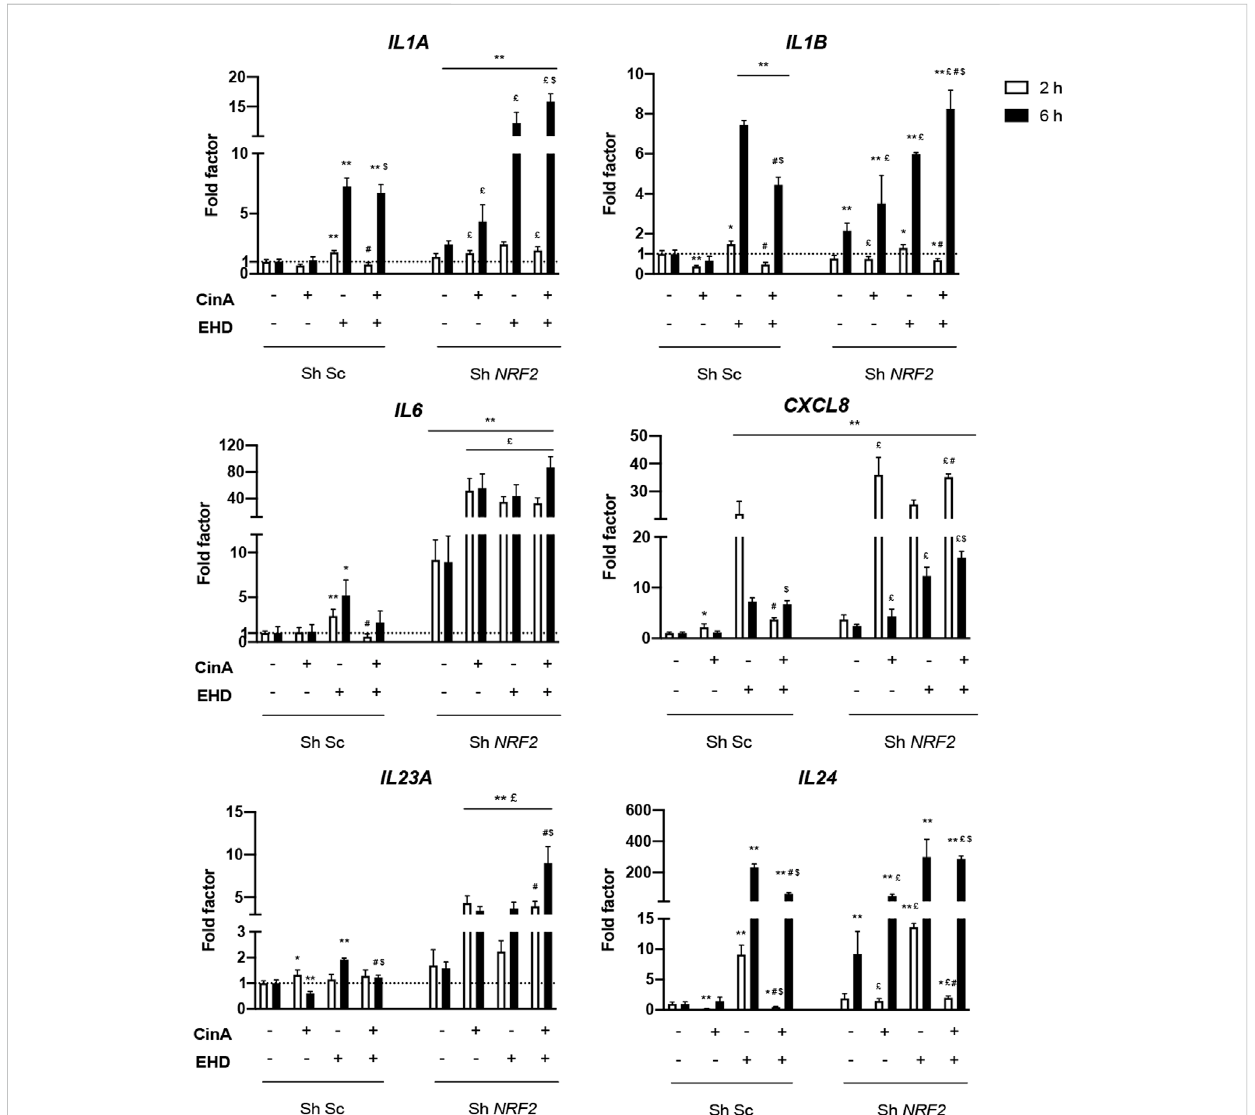
FIGURE 3 NRF2 inhibits in fl ammation in KERTr cells exposed to EHD and the mixture of EHD and CinA . Control KERTr cells (Sh Sc) and NRF2 -invalidated KERTr cells (Sh NRF2 ) were treated for 2 and 6 h with CinA (100 μ M), EHD (10 μ M), a mixture containing CinA and EHD at the same concentrations and PBS (0.1%) as vehicle control. After treatment, expressionat genelevel of IL1A,IL1B, IL6, CXCL8, IL23A , and IL24 , encoding, respectively, IL-1 α , IL-1 β , IL-6, IL-8, IL-23, and IL-24, were quanti fi ed by RT-qPCR and normalized with ACTB and GAPDH expression at gene level. Results are expressed as the mean ± SEM of three duplicated independent experiments. * indicates signi fi cant differences from untreated control Sh Sc KERTr cells